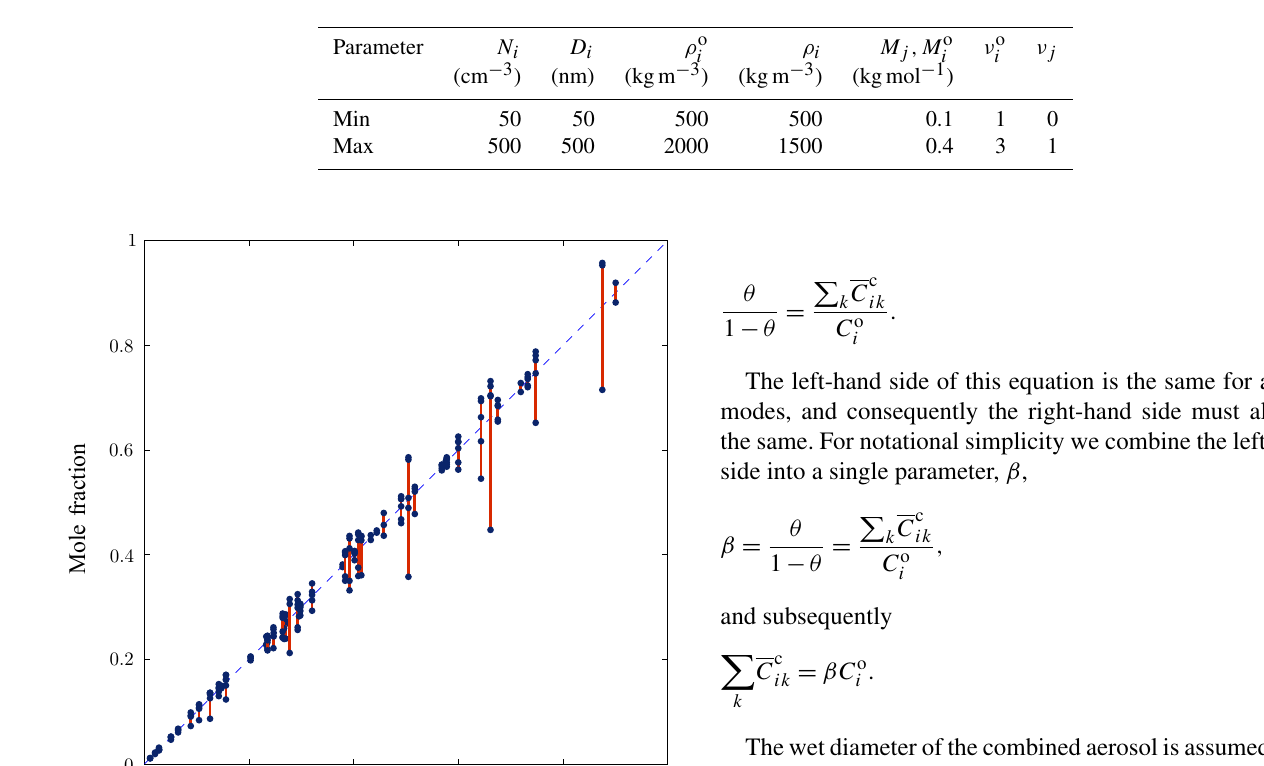
Table 1. Randomised parameters used to plot Fig. 3. N i , D i , ρ o weight of the i th involatile aerosol, respectively. ν o